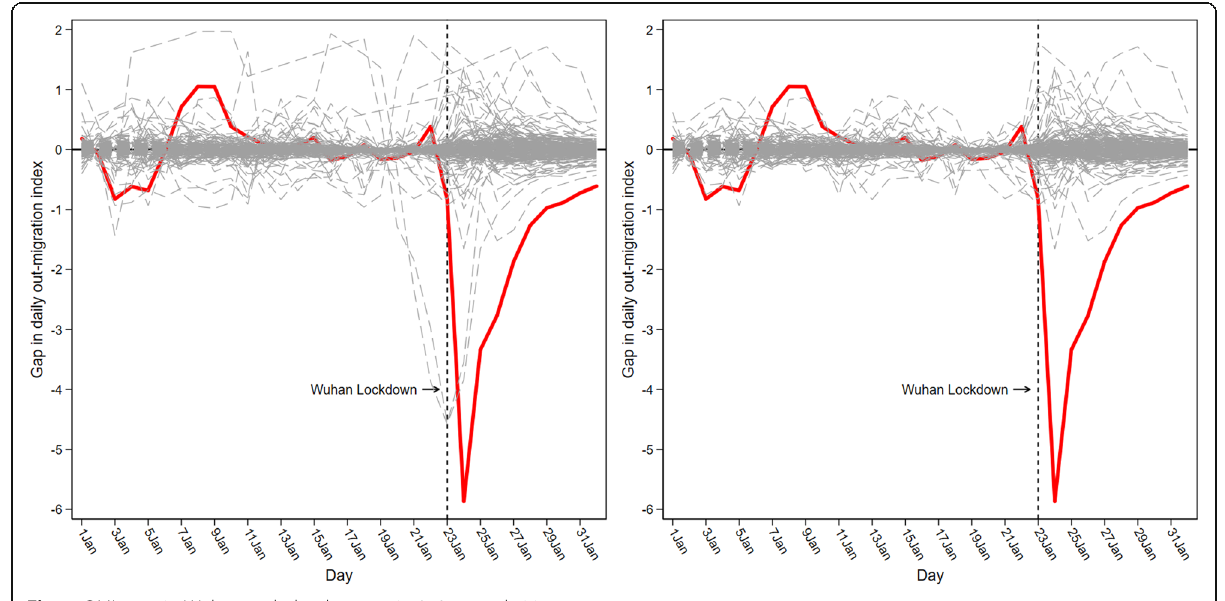
Fig. 5 OMI gaps in Wuhan and placebo gaps in 278 control cities